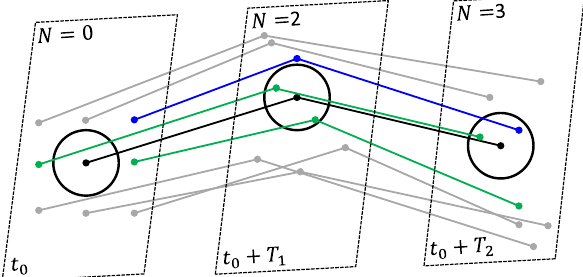
Figure 1. Schematic diagram of trajectory encounters, showing tra- jectories of nine particles, with dots indicating positions of particles at three time instances, at the release time, t 0 , and at two later times, t 0 + T 1 and t 0 + T 2 . The reference trajectory and the encounter sphere are shown in black, trajectories that do not encounter the reference trajectory are in grey, and trajectories that encounter the reference trajectory are in green if encounters occur at t 0 + T 1 , and in blue if encounters occur at t 0 + T 2 . Time slices are schematically shown by dashed rectangles, and the encounter number, N , is indicated at the top of each time